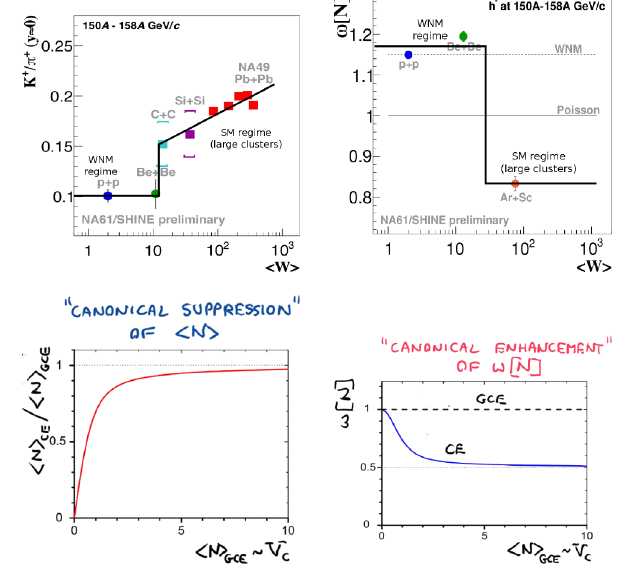
Figure 5. ( Top.) K + / π + ra- tio ( left) and multiplicity fluc- tuation ( right) versus number of wounded nucleons. A “jump” between light / intermediate and heavy systems is seen. ( Bottom.) Possible impact of canonical suppression of (cid:104) N (cid:105) on K + / π + ra- tio ( left), and canonical enhance- ment of ω [N] on ω [N] (